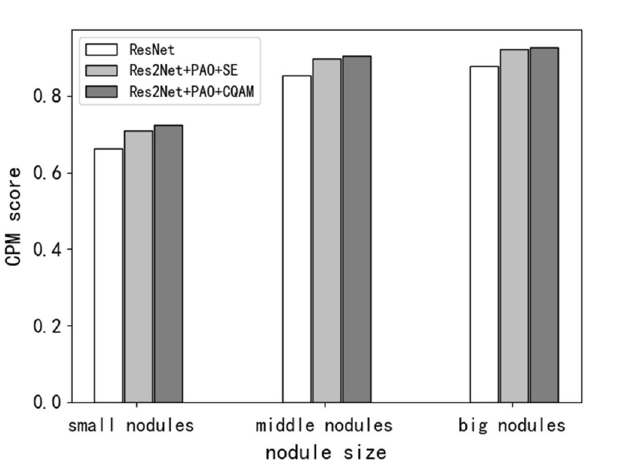
Figure 8. CPM scores of different nodule